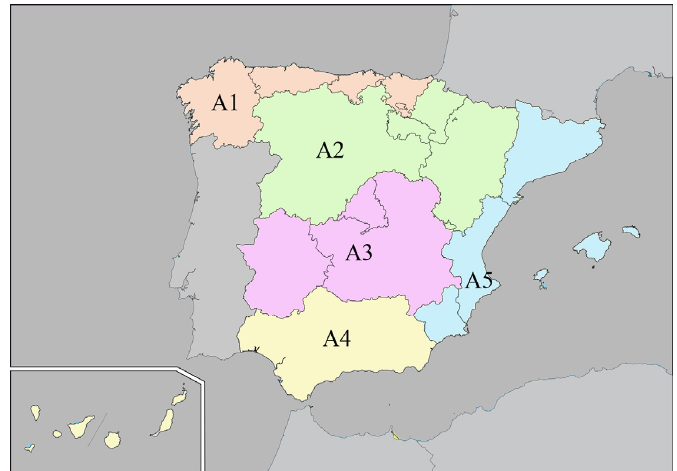
Figure 2. Map of Spain with the five studied areas. Area 1 (A1, orange); Area 2 (A2, green); Area 3 (A3, purple); Area 4 (A4, yellow); and Area 5 (A5, blue).